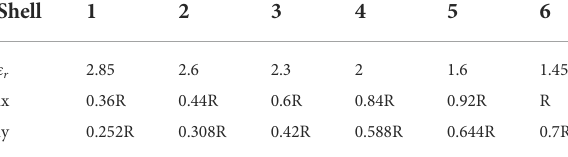
TABLE 1 Gradient permittivity and